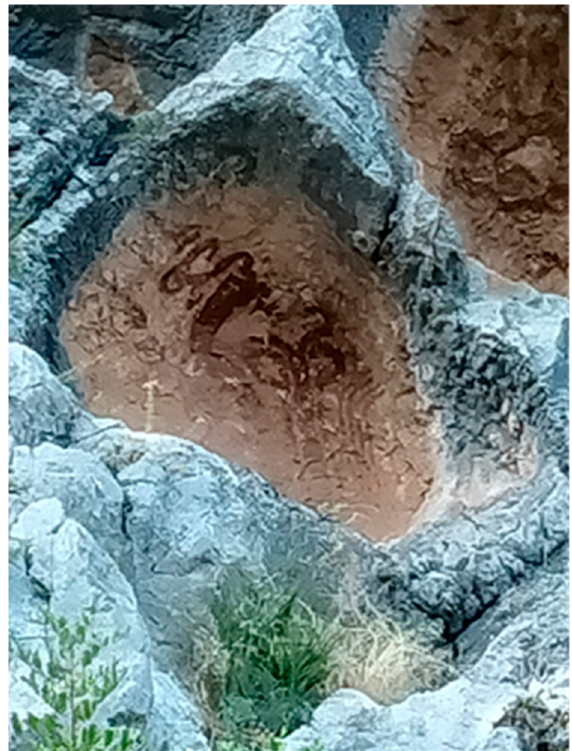
Figure 26. Shelter VIII. The head of a bull and its antlers. This photo was taken by the author.